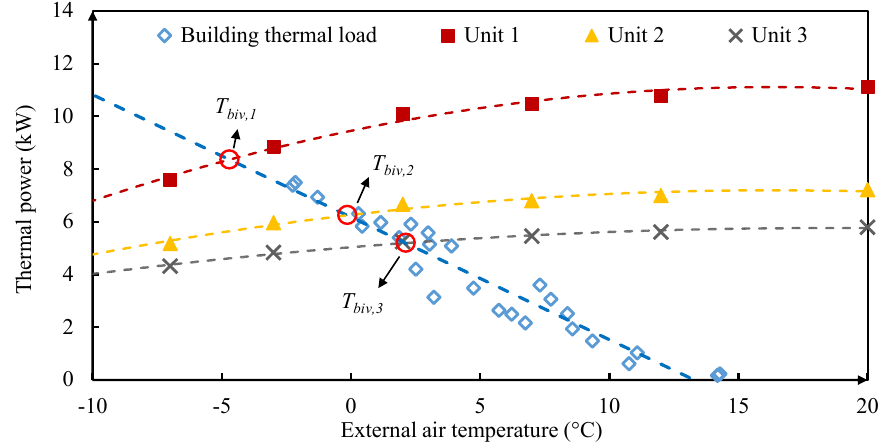
Figure 4. Building thermal load and heat pump heating capacity at full load as a function of external air temperature.